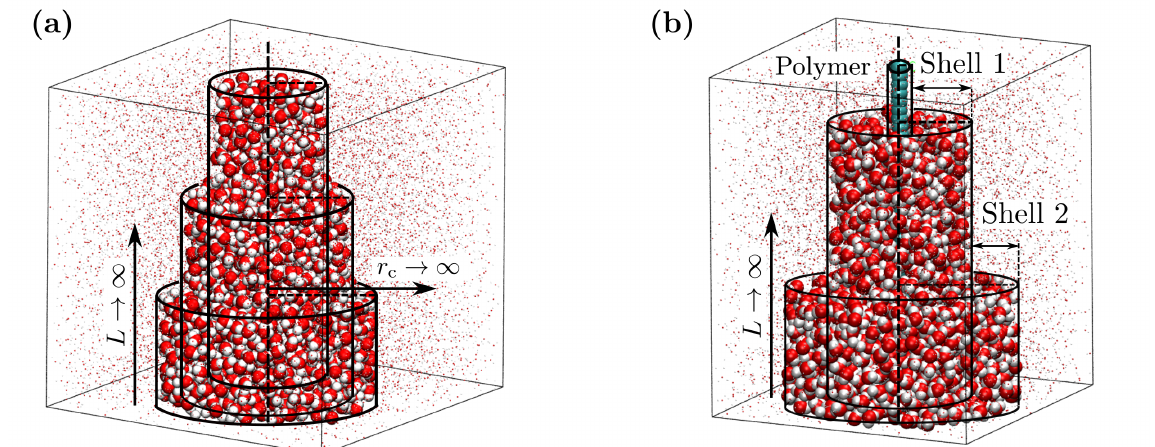
Figure 2. Observation volumes used in this work to estimate thermodynamic properties. ( a ) The isothermal compressibility of SPC/E water is estimated using cylindrical observation volumes, where the TL corresponds to both 1/ L → 0 and 1/ r c → 0. ( b ) The thermodynamical quantities pertaining to polymer hydration shells are estimated using concentric cylinders as observation volume. Here, the TL corresponds to 1/ L → 0.